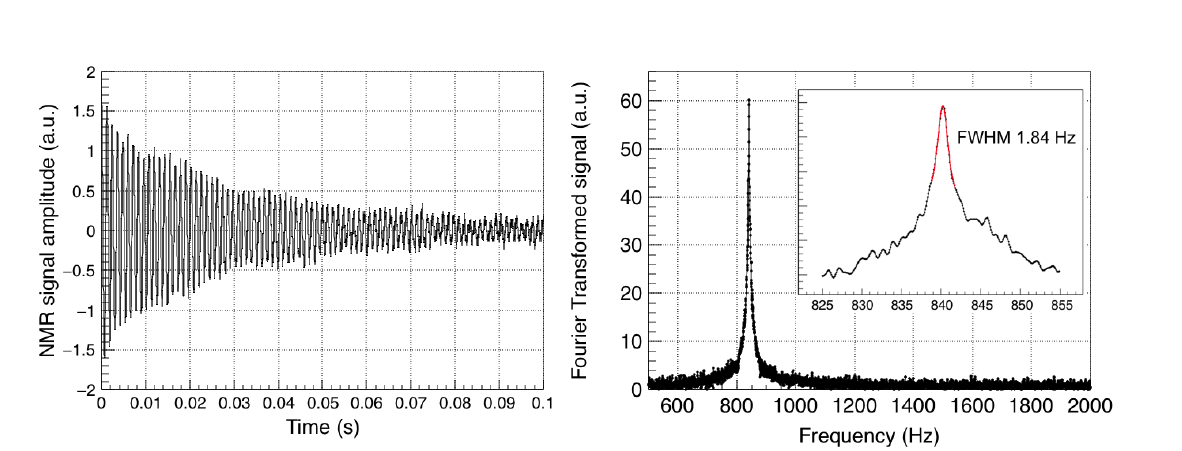
Figure 9. ( left ) The raw field induced decay signal of 3 He at 5.3 T. The spin precession signal is amplified and mixed down before recorded. ( right ) Fourier transformation of the raw field induced signal. The peak at 840 Hz is the 3 He NMR signal. Inset shows the peak and fitting by a Lorentzian function. The best fit result gives a FWHM of 1.84 Hz.